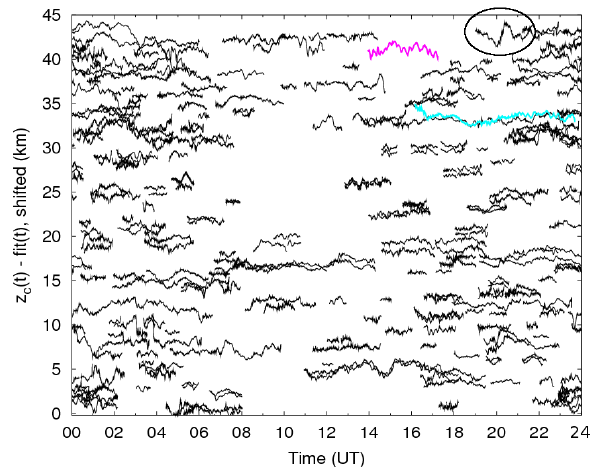
Fig. 3. Time series z c (t) , shown as a function of time of day for all years 2008–2011 and both telescopes. A linear trend was removed. Only measurements longer than 0.5h are included (in total 291 time series). For better visualization, the baseline of the curve was shifted upwards in altitude for each NLC measurement. The two examples discussed in more detail in this paper are shown in color (19 July 2011 in pink, 25 July 2010 in light blue).